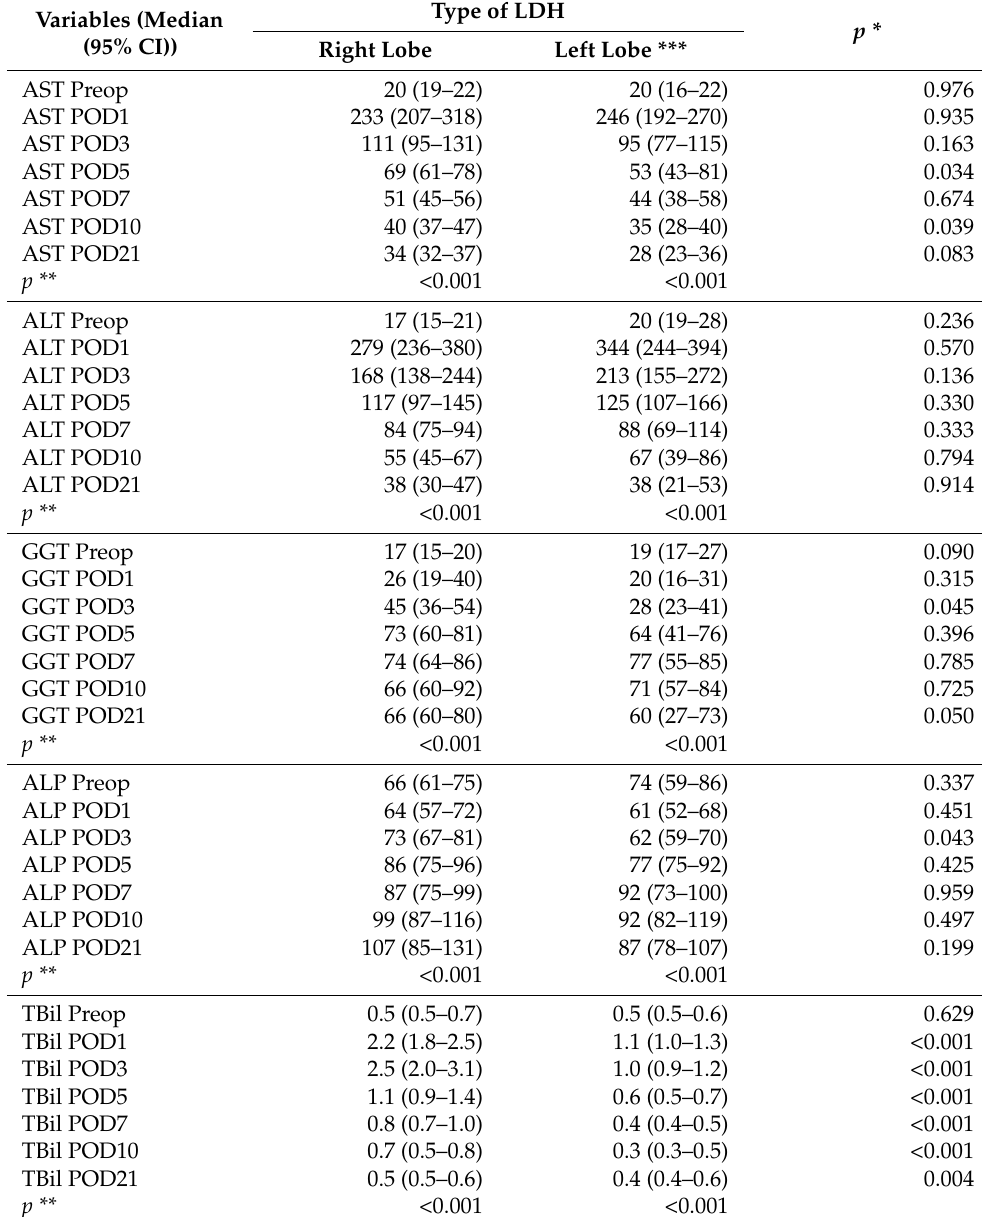
Table 3. Comparison of study subgroups created according to type of hepatectomy (right-lobe LDH vs. left-lobe LDH) type in terms of routine biochemical